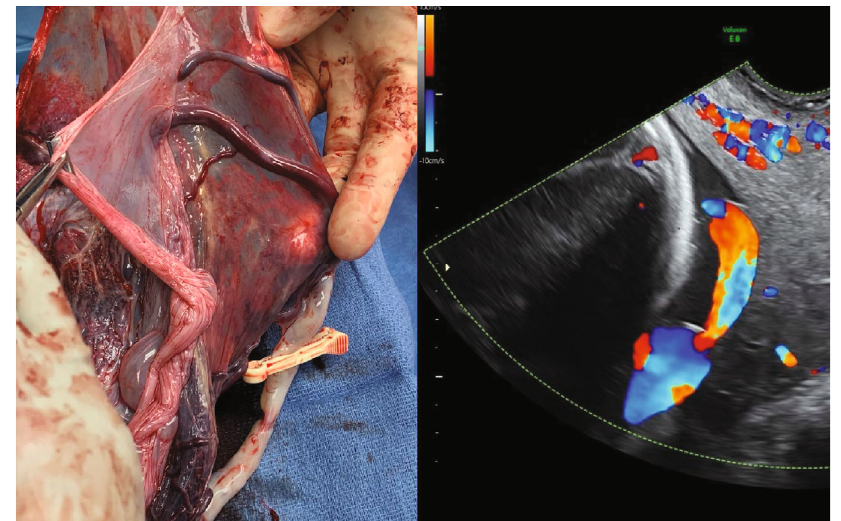
Figure 5: Gross image of the placenta with corresponding ultrasound. Ultrasound image shows proximity of fetal vessel to cervix.